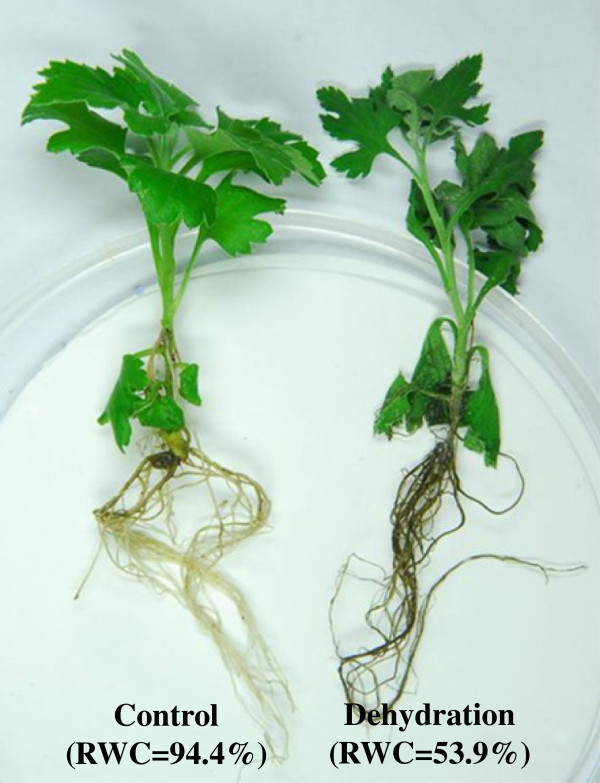
Chrysanthemum plants under dehydration and well-watered conditions.